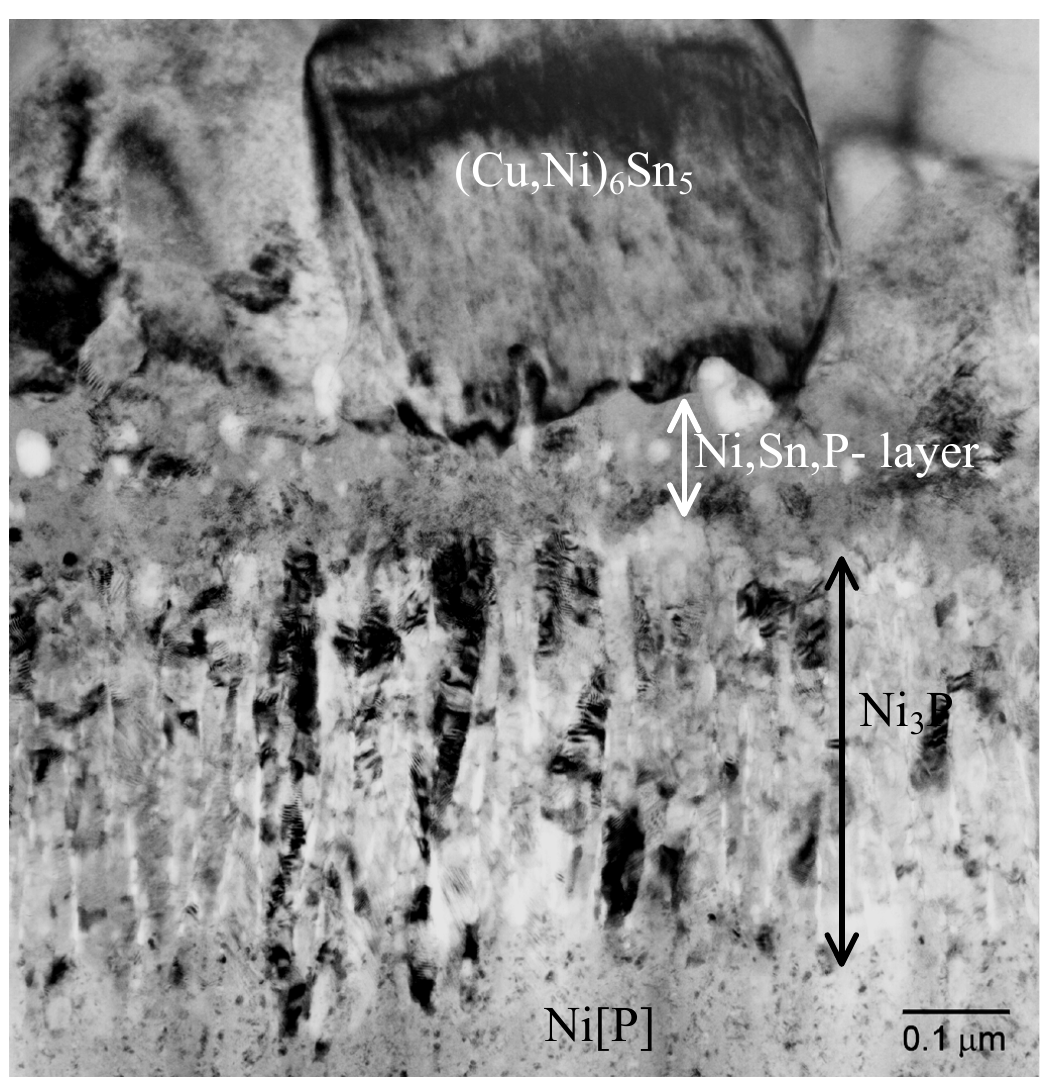
Figure 7. Bright field image from the reaction zone in the sample that has been annealed at 170 °C for 64 hours after the assembly